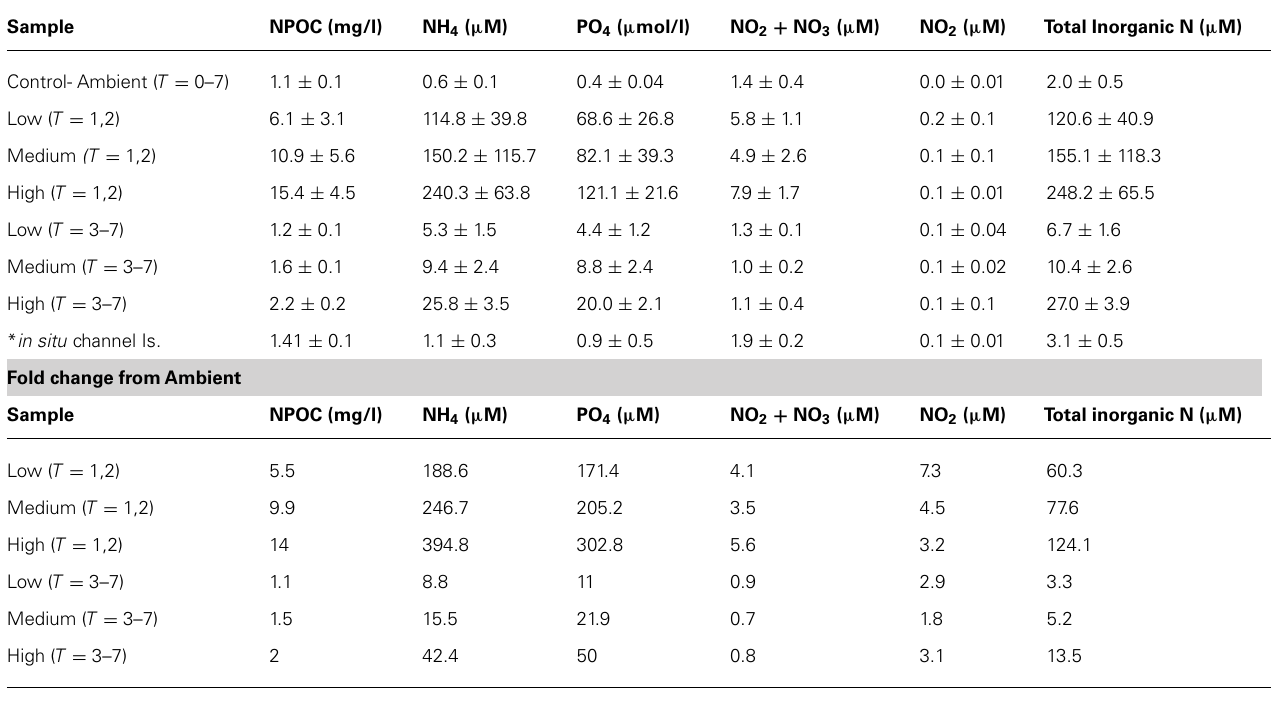
Table 1 | Nutrient parameters measured over the course of the 7 day experiment (three replicate water samples averaged per treatment). Sample